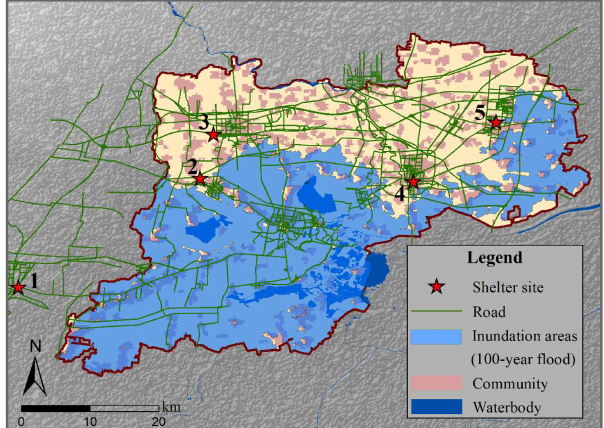
Figure 6. Flood inundation areas for a 100-year flood in the study